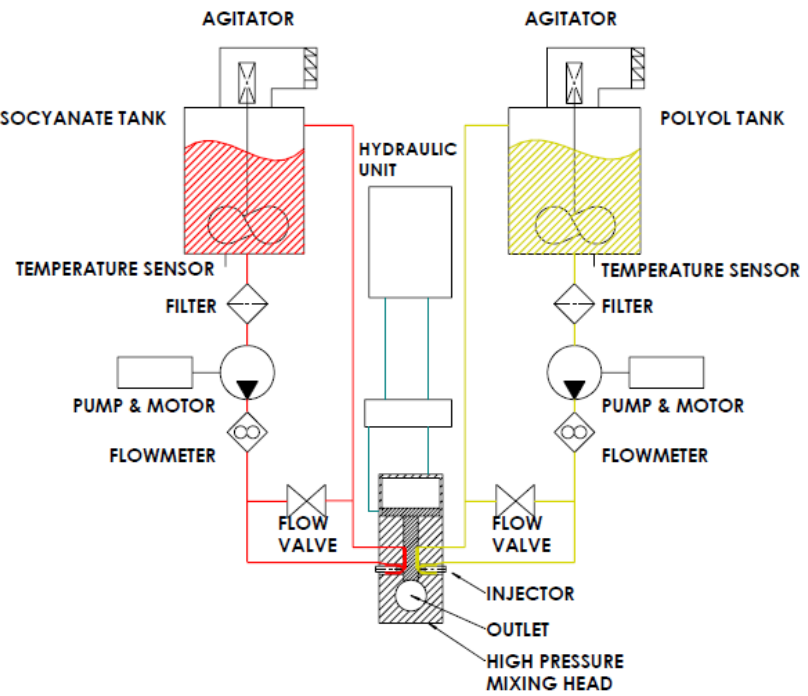
Figure 1. General scheme of a high-pressure machine.